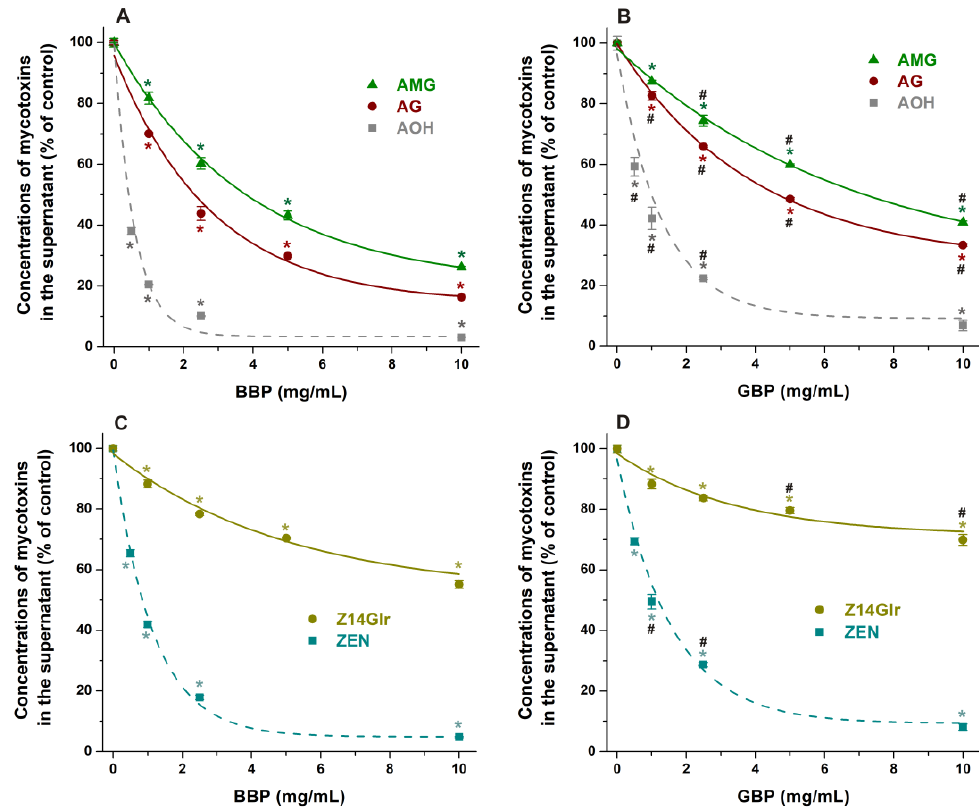
Figure 8. Impacts of insoluble β - CD bead polymer (BBP; ( A , C )) and γ - CD bead polymer (GBP; ( B , D )) on mycotoxin levels in sodium acetate buffer (0.05 M, pH 5.0), where alternariol - 3 - glucoside (AG), alternariol - 9 - monomethylether - 3 - glucoside (AMG), and zearalenone - 14 - glucuronide (Z14Glr) solutions (each 5 μM) were treated with increasing amounts of these polymers (0–10 mg/mL; see further experimental details in Section 2.4). For comparison, the extraction of the parent mycotoxins alternariol (AOH) and zearalenone (ZEN) by BBP and GBP is also presented (marked with dashed lines). Data represent the mean and standard error of the mean (SEM) ( n = 3). Statistical significance was established based on one - way ANOVA with Tukey’s post hoc test (* p < 0.01: significant difference compared to the control; # p < 0.01: significant difference between BBP and GBP, see in panels ( B , D )).